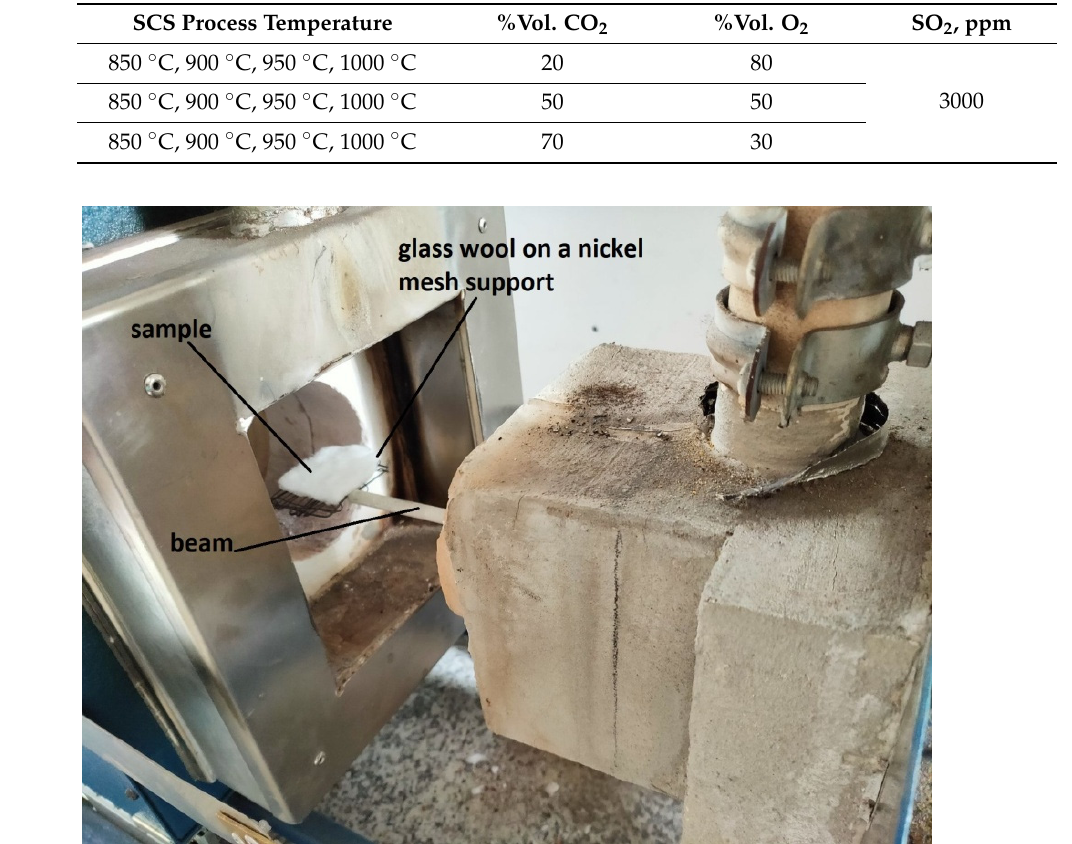
Table 4. Experimental conditions used for the analysis of sorbent properties during oxy-combus- tion.